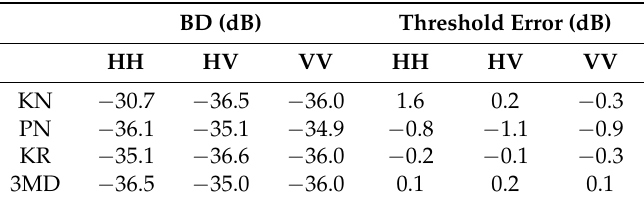
Table 8. Goodness of fit metrics for the model fits in Figure 12. Threshold error is measured at a CCDF of 10 − 4 .